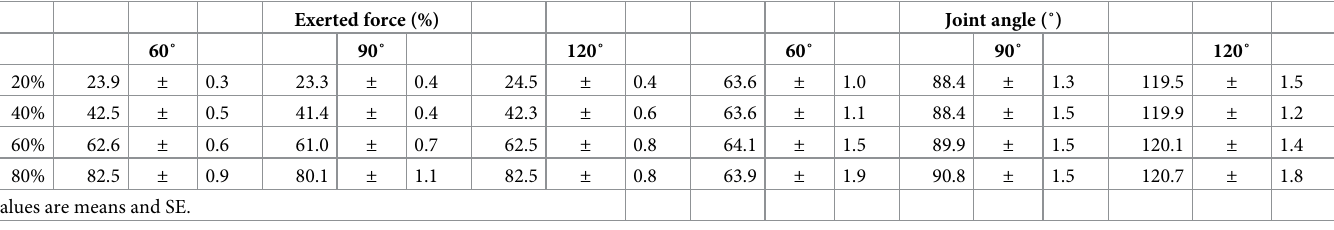
Fig 4. Comparisons of normalized root mean square (RMS) of electromyographic signals and normalized isometric maximum voluntary contraction (MVC) force relationships with respect to the medial (TB-Med), lateral (TB-Lat), and long (TB-Long) heads of the triceps brachii at 60˚, 90˚, and 120˚ of extension. ††, P < 0.01 vs TB-Lat; a, P < 0.001 vs other muscles. https://doi.org/10.1371/journal.pone.0252644.g004 significantly lower than the values at 60˚. The RMS during 80%MVC at 120˚ was also signifi- cantly lower than that at 90˚ (P = 0.022).